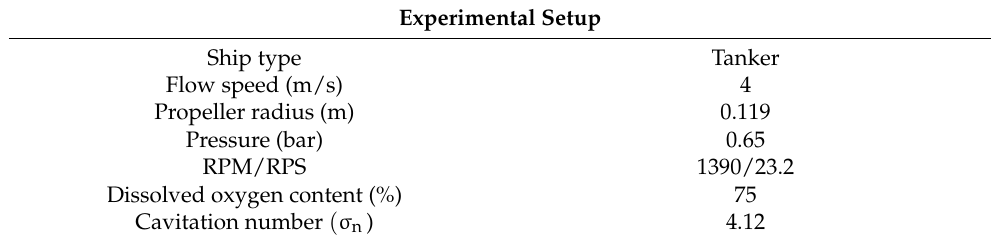
Table A1. Experimental Setup for incipient TVC.